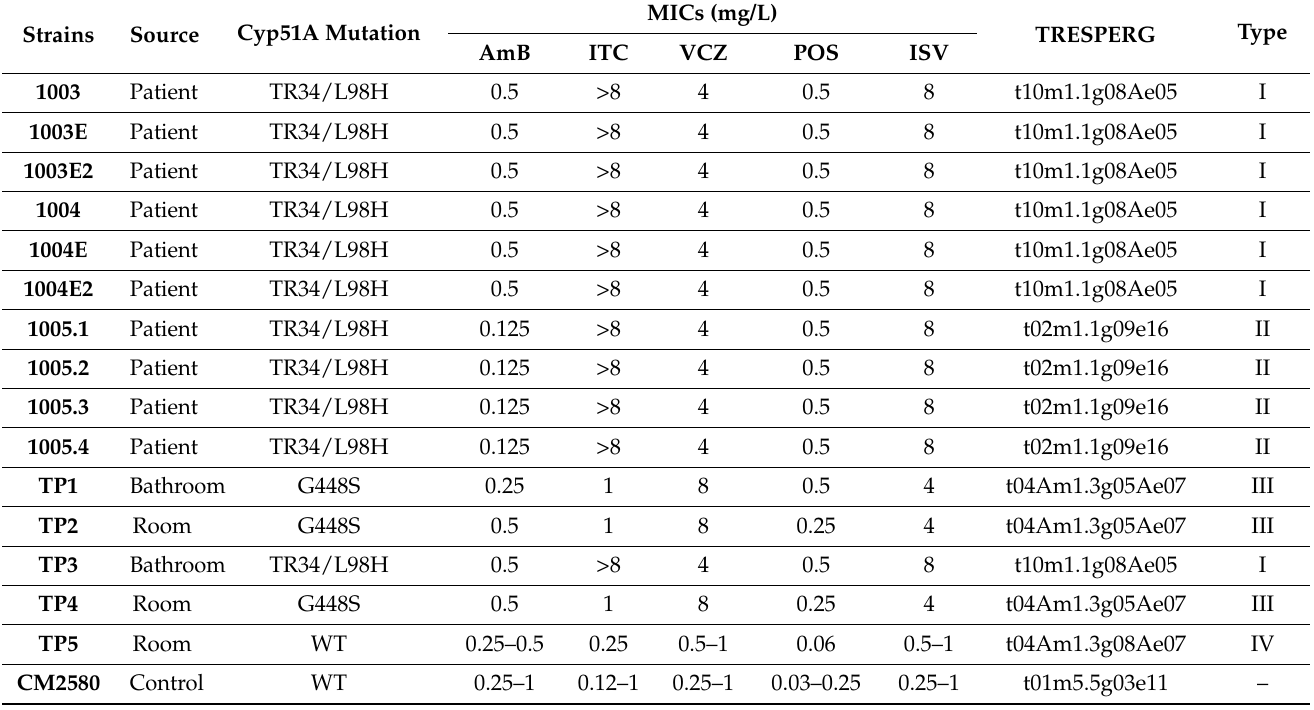
Table 1. Minimal inhibitory concentrations (MICs), azole resistance mechanisms and TRESPERG typing assay of fifteen A. fumigatus strains. (AmB: amphotericin B; ITC: itraconazole; VCZ: voriconazole; POS: posaconazole; ISV: